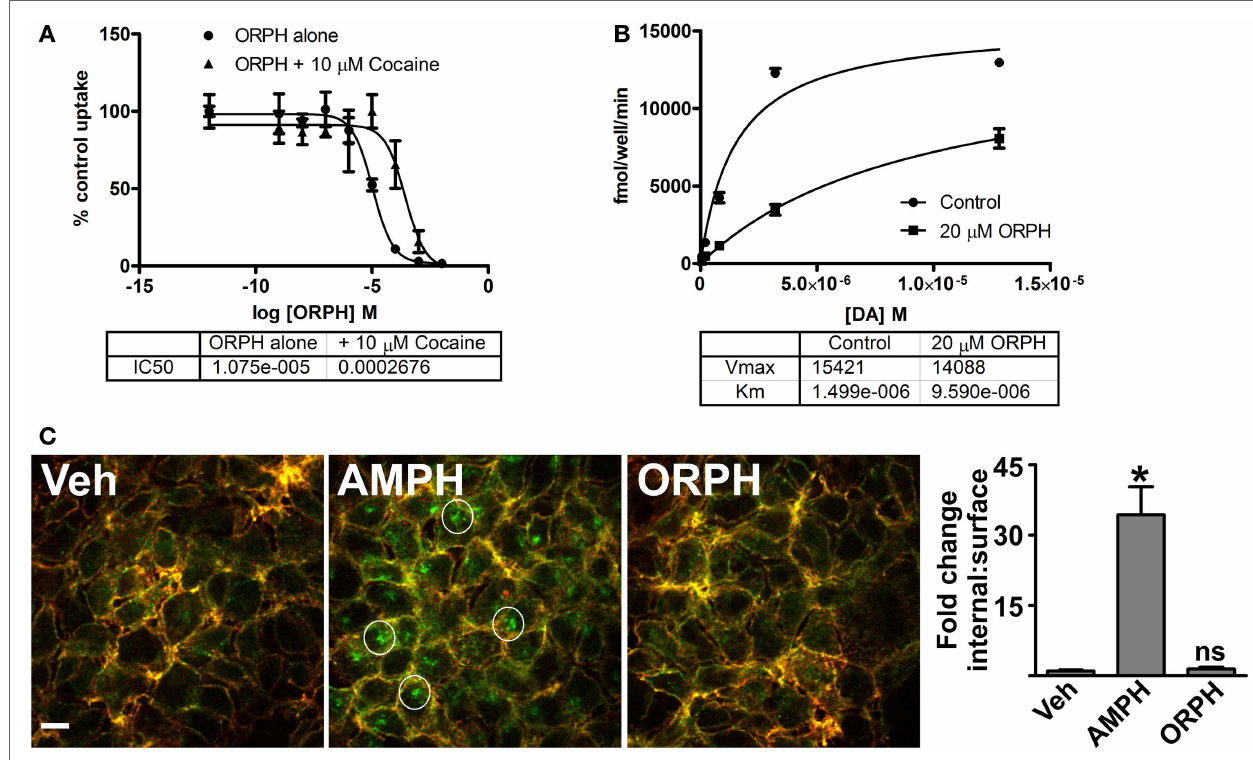
expressing HA-DAT were treated for 30 min with water vehicle (Veh), Figure 8 | (a) Competitive inhibitory properties of ORPH confirmed by 100 μ M amphetamine (AMPH), or 100 μ M orphenadrine (ORPH) and were experiments. Uptake of 3 H-DA by PAE cells expressing human DAT was subjected to the “HA antibody feeding” assay as described in section measured in the presence of the indicated concentration of orphenadrine “Materials and Methods” prior to imaging by confocal fluorescence (ORPH) alone or following 10 min pre-treatment with 10 μ M cocaine. microscopy. Surface transporters appear red and green (yellow), while Means of three replicates ± SEM were plotted as a percentage of the intracellular transporters appear in green only. Examples of endocytosed uptake remaining from lowest ORPH concentration in respective group HA-DAT (green) are circled. Representative images from three replicates are (either alone or with cocaine). ORPH concentration for 50% inhibition of shown. The fold change in the ratio of IC:surface transporters was dopamine uptake (IC50) was calculated. (B) Uptake of the indicated determined by quantitative analysis of surface and IC signals as described concentrations of 3 H-DA by PAE cells expressing hDAT was measured in in section “Materials and Methods.” Values are the means of eight the presence of no drug (control) or following 10 min pre-treatment with determinations and error bars are standard deviations. Significant difference 20 μ M ORPH. Mean ± SEM of three replicates were plotted and Michaelis– from vehicle (* p < 0.05) was determined by one-way ANOVA followed by Menten non-linear regression analysis was performed, providing transporter the Tukey post-test for multiple dopamine affinity ( K ) and capacity ( V ) for each condition. (c) HEK cells m max